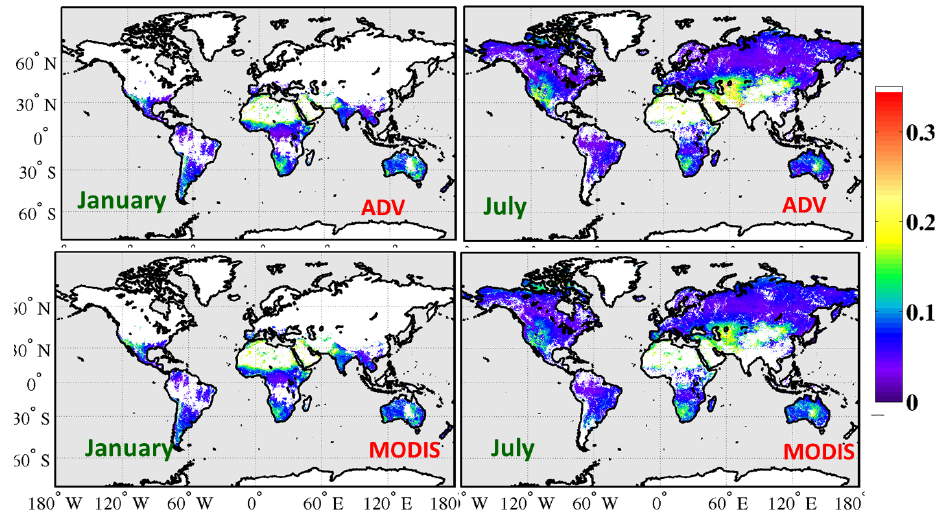
Figure 8. ADV (upper panel) and MODIS-derived surface reflectances matching the AATSR viewing geometry (lower panel) for 555nm for January (left) and July (right).